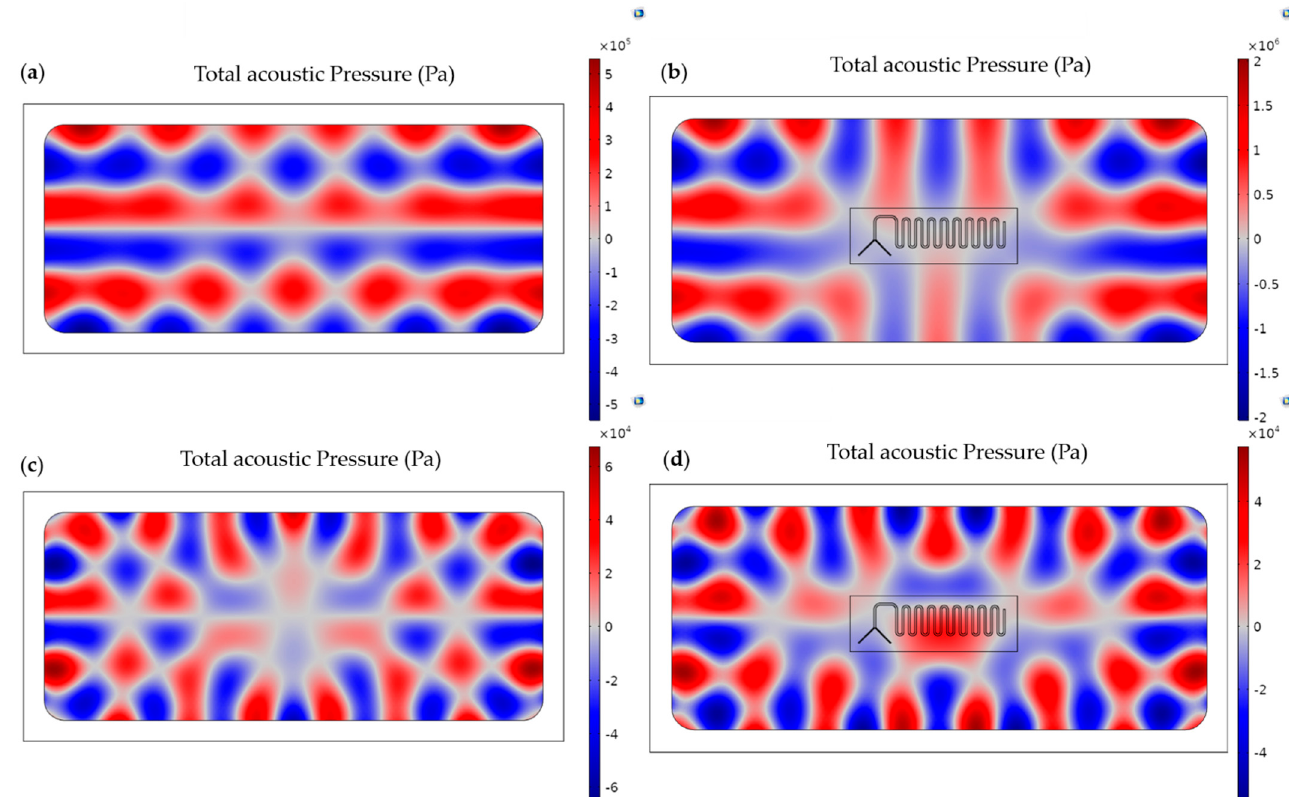
Figure 4. Simulation results for the total acoustic pressure field [Pa] inside the ultrasonic bath for operating frequencies of 37 kHz and 45 kHz. ( a ) Total acoustic pressure field at 37 kHz in the absence of the microfluidic device; ( b ) Total acoustic pressure field at 37 kHz in the presence of the microfluidic device; ( c ) Total acoustic pressure field at 45 kHz without the microfluidic device; ( d ) Total acoustic pressure field at 45 kHz with the microfluidic device.